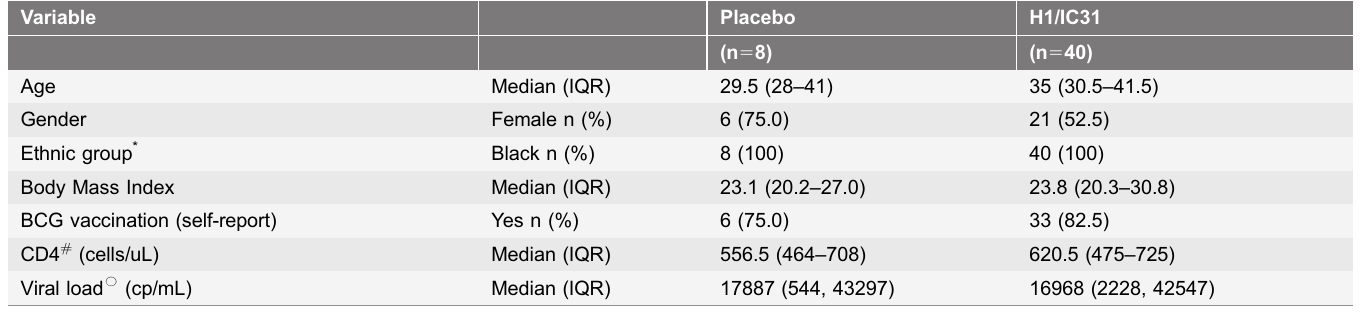
Table 1. Demographic and baseline characteristics of the study participants by vaccination